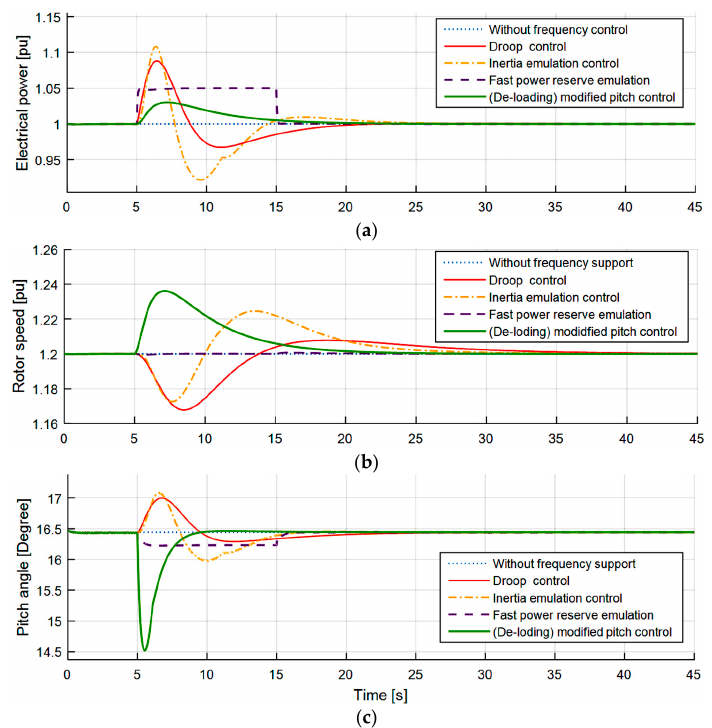
Figure 16. ( a ) Electrical power; ( b ) rotor speed; and ( c ) pitch angle of VSWT in high wind speed case after frequency